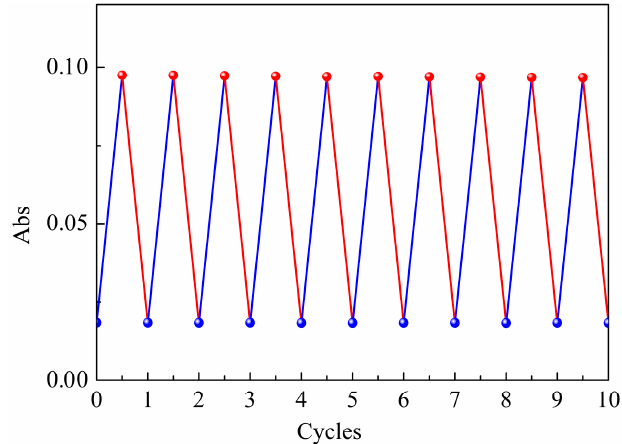
Figure 10. Absorbance of NC-g-AISO membrane at 598 nm during photochromic cycles.